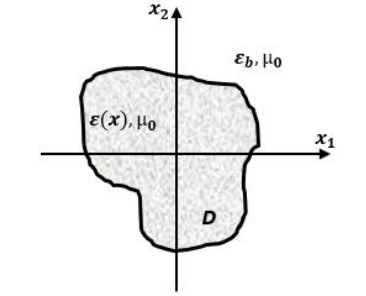
Figure 1: Geometry of the